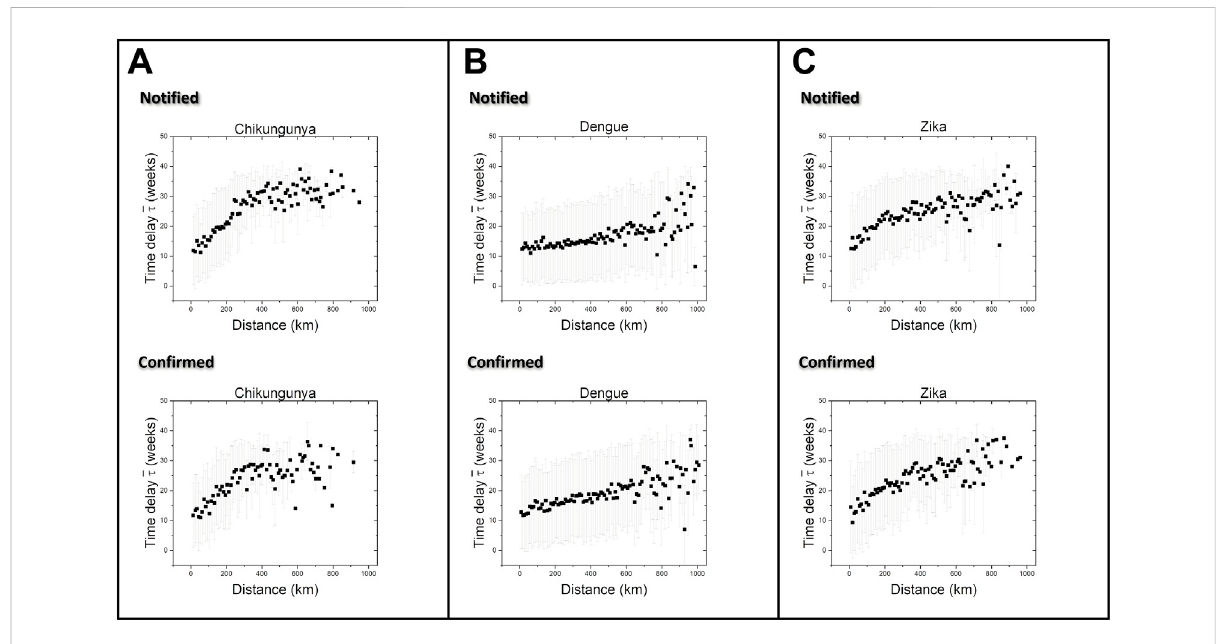
FIGURE 7 Dependence of delay time vs. distance for noti fi ed and con fi rmed networks. (A) Chikungunya. (B) Dengue. (C)